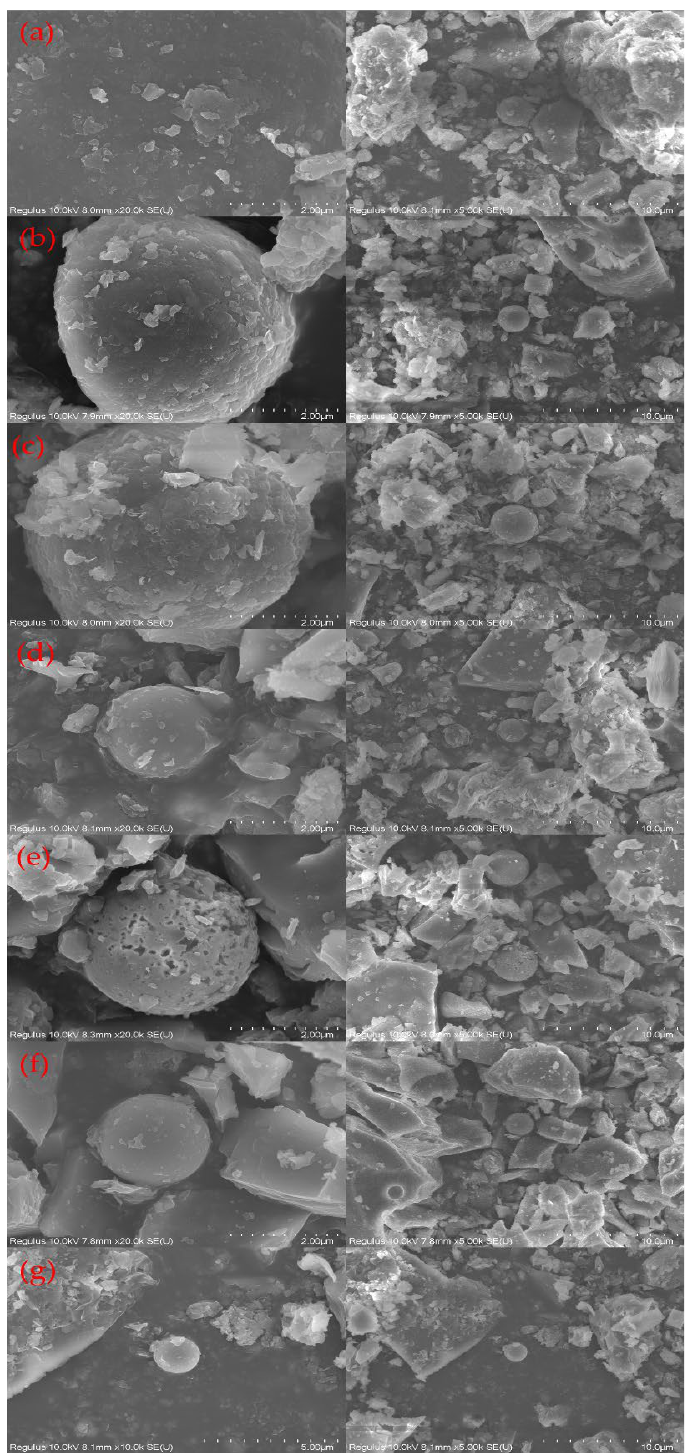
Figure 2. SEM characterization of catalysts: ( a ) γ -Al 2 O 3 sample; ( b ) 400 °C, ( c ) 500 °C, ( d ) 600 °C, ( e ) 700 °C, ( f ) 800 °C, ( g ) 900 °C. ( e ) 700 ◦ C, ( f ) 800 ◦ C, ( g ) 900 ◦